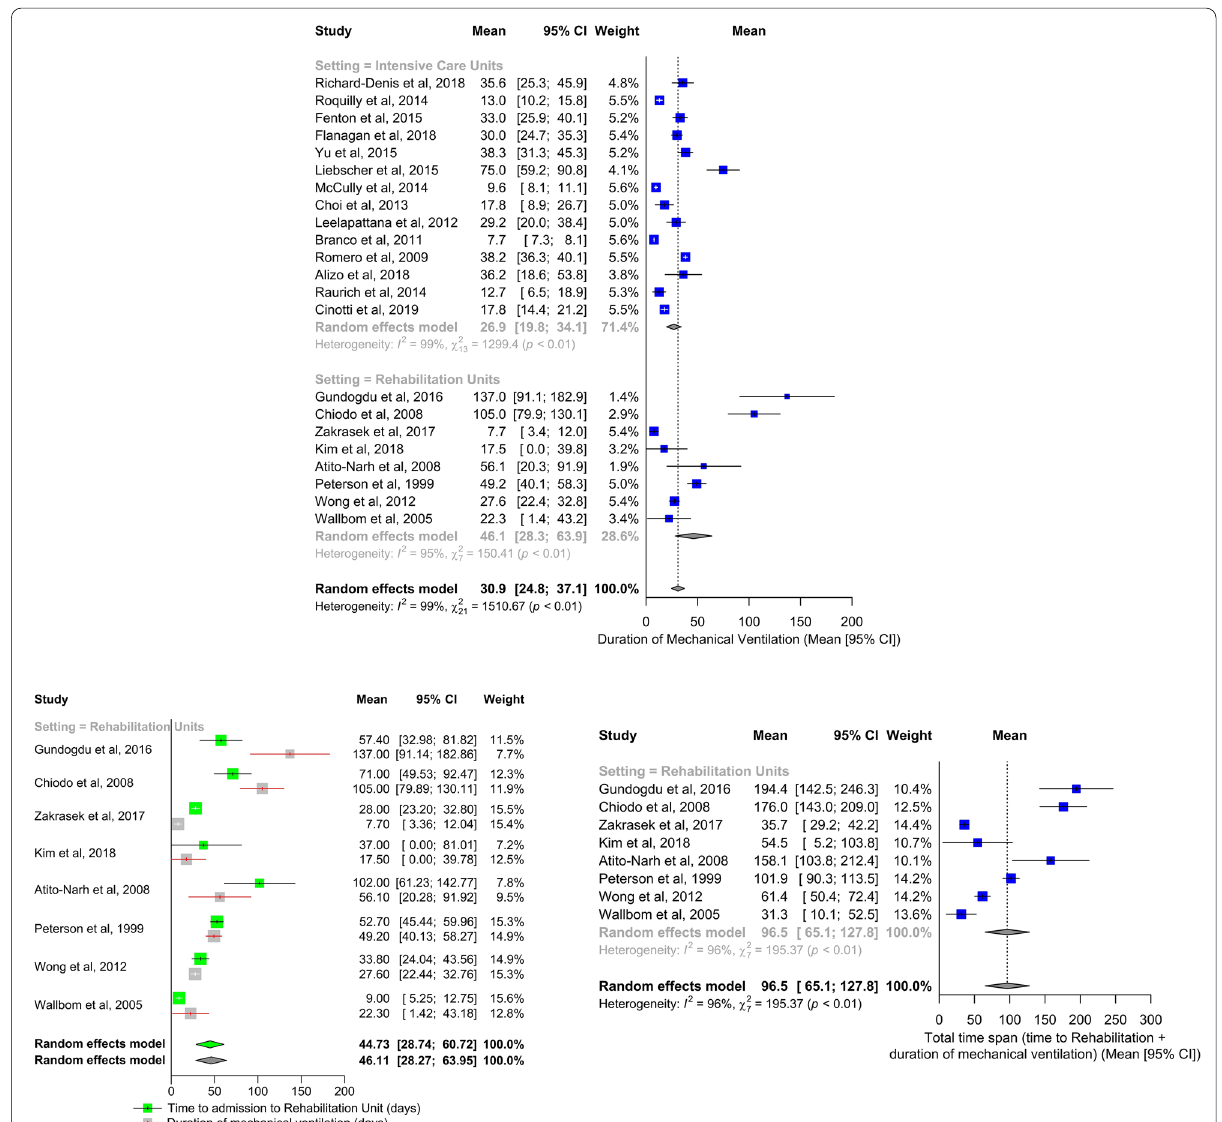
Fig. 3 Forest plot for the outcome of duration of mechanical ventilation in intensive care units and rehabilitation units (upper panel). Studies are presented according to setting classification (intensive care units vs rehabilitation units): both overall and subgroup estimates are reported. Forest plots for the outcome of duration of mechanical ventilation for rehabilitation units (including the time to admission to rehabilitation) (lower panels). Weight refers to the relative contribution of each study to the meta-analytic estimate and is generated using the inverse variance